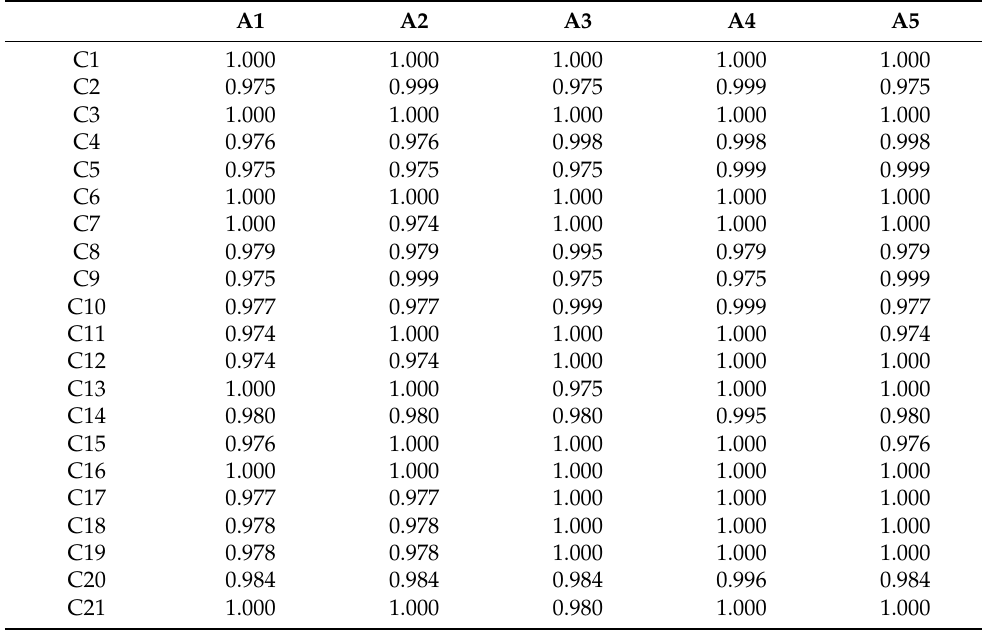
are calculated by using S 1 formula (Table 7). GC Table 7. The matrix of distances to the border approximation area Q